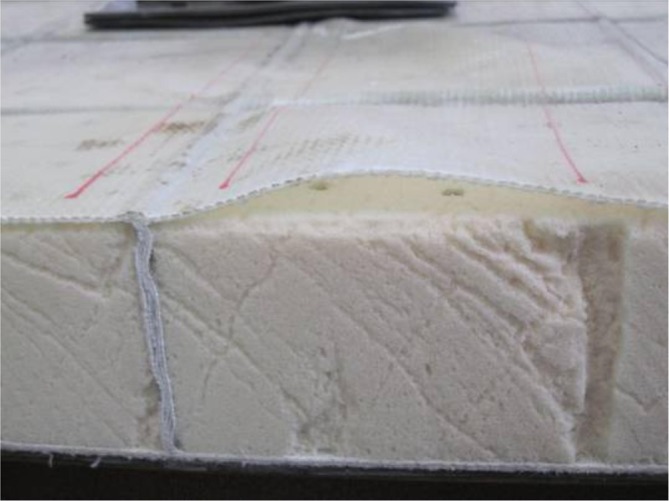
Photograph of the failure of specimen SX75-175.